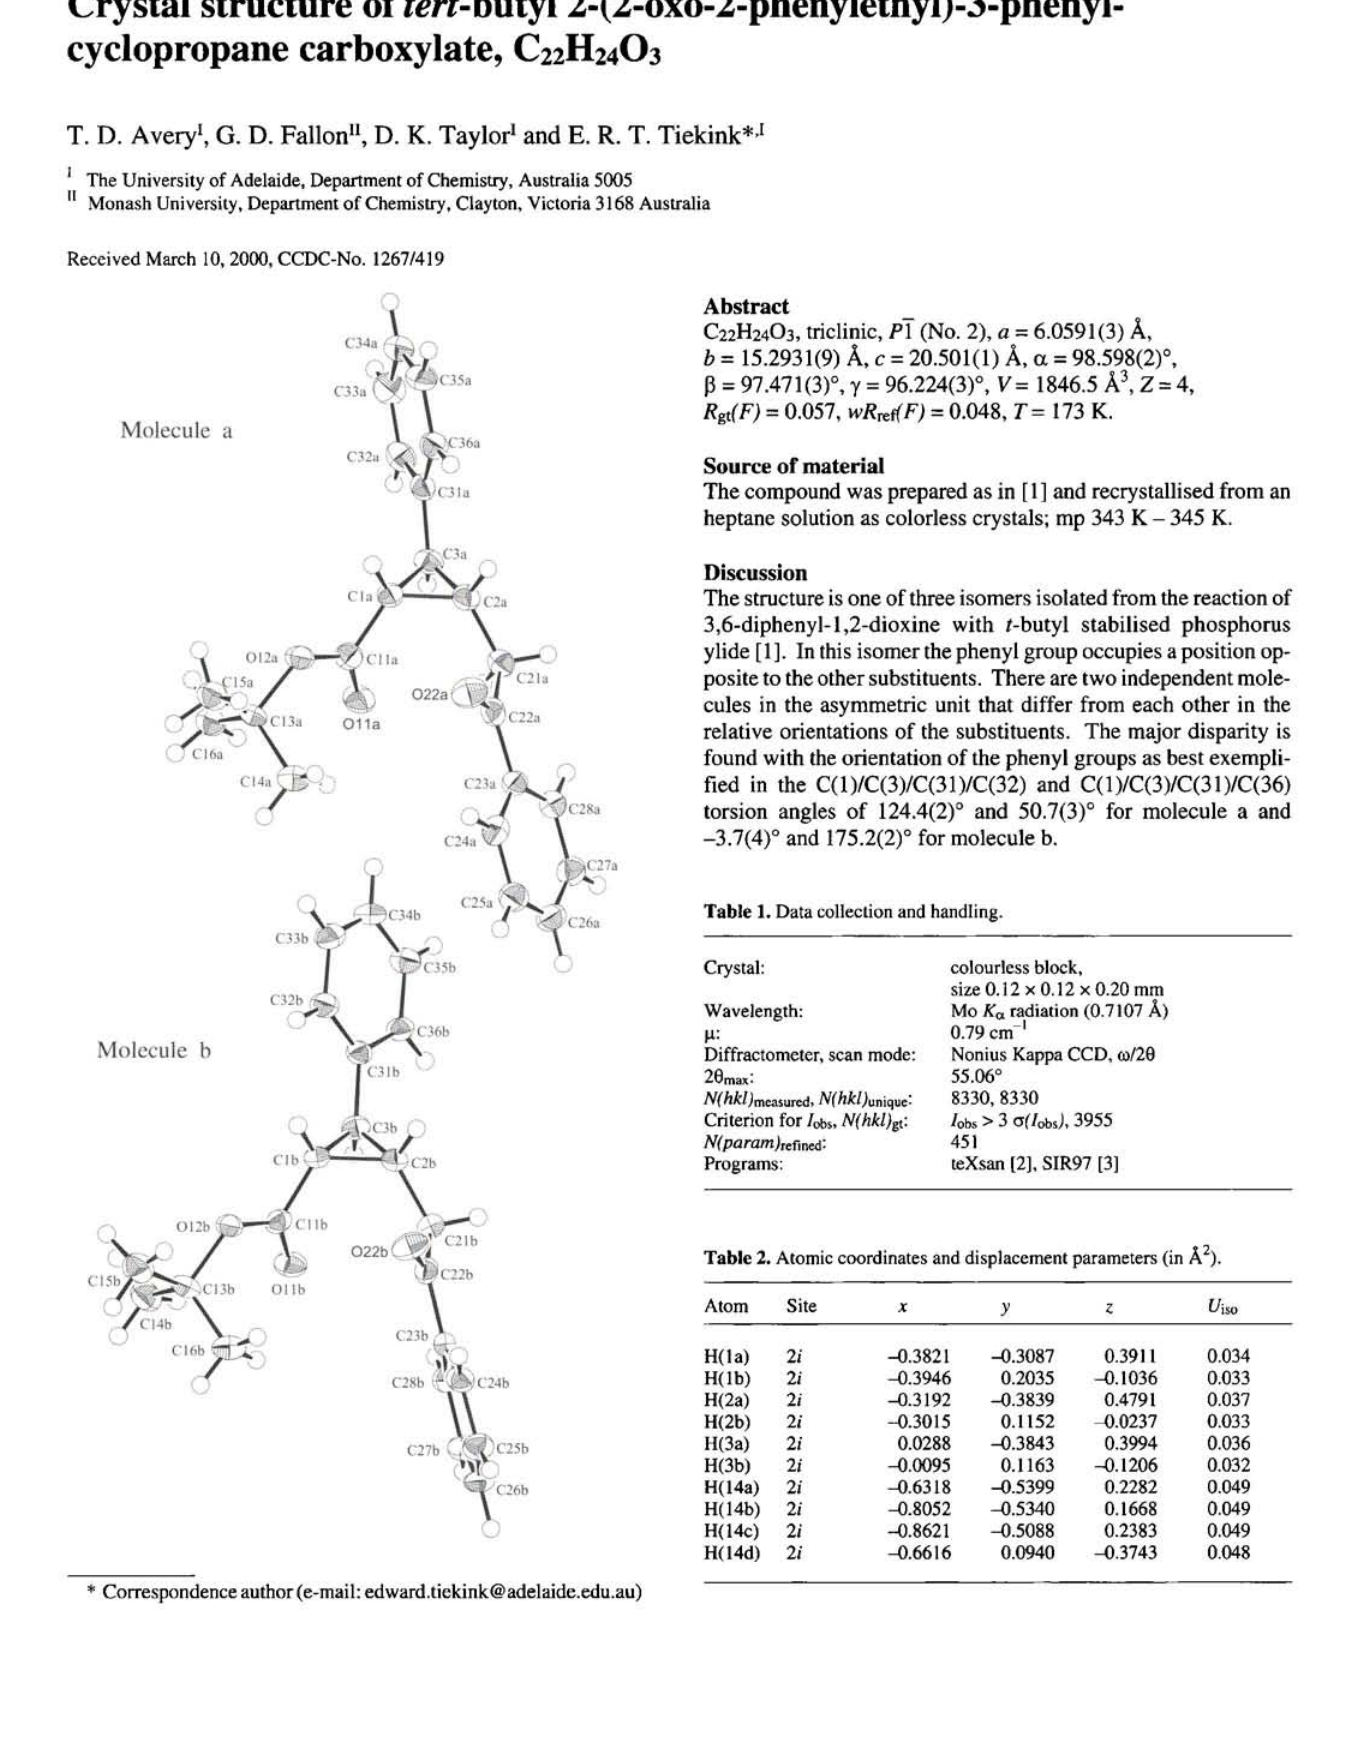
Table 1. Data collection and handling.